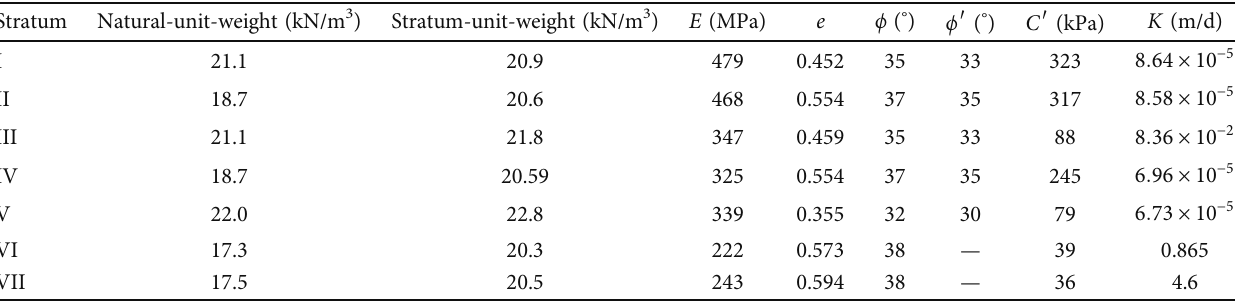
Figure 4: Two-dimensional fi nite element model of Chana landslide. Table 1: Strength parameters of rock and soil